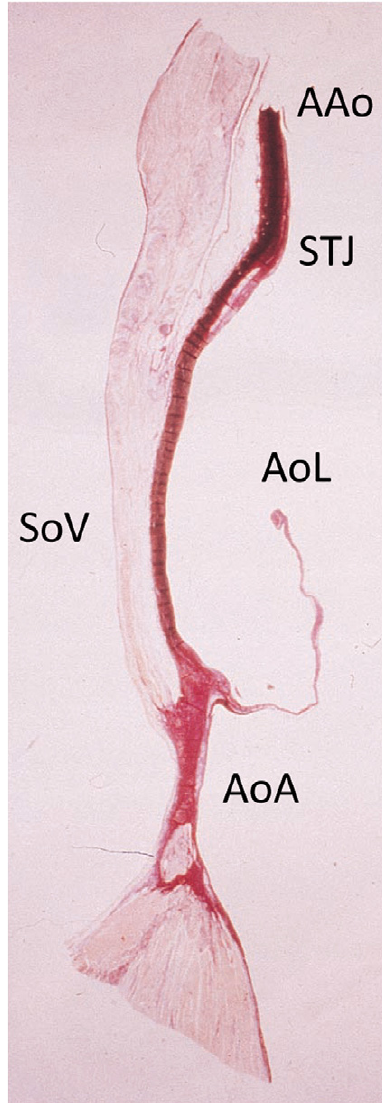
Figure. 1 Longitudinal section of the normal aortic valve. The aortic annulus (AoA) is a crown-shaped three- pointedstructure,inspiteofitsname,whichimpliesaring.Theannulusisadefinitefibrousstructurethat,apart from giving origin to the aortic leaflets (AoL), is firmly attached to the media of aortic sinuses distally, while proximally it is attached to the muscular and the membranous septa anteriorly, the fibrous trigones laterally, and the subaortic curtain posteriorly. The latter three structures, together with the annulus, form part of the fibrous framework of the heart. The sinuses of Valsava (SoV) constitute three almost symmetrical bulges in the aorticrootextendingfromtheaorticannulustothesinotubularjunction(STJ),wheretherootjoinstheascending aorta(AAo).Themediaoftheaorticsinusesdiminishprogressivelyinthicknessfromthelevelofthesinotubular junction towards the annulus, where it is firmly